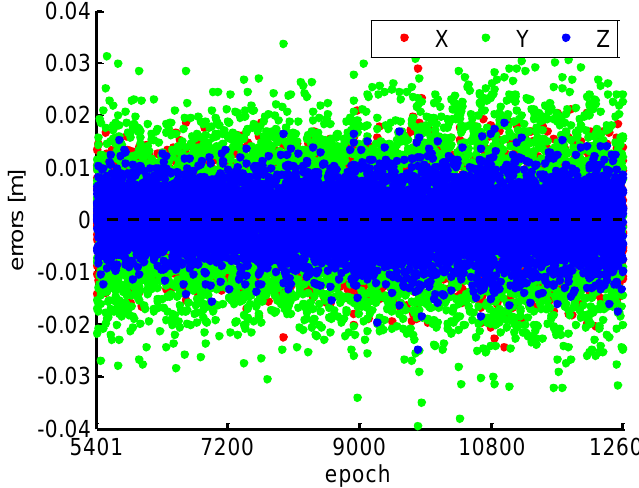
Figure 6. Relative position errors.